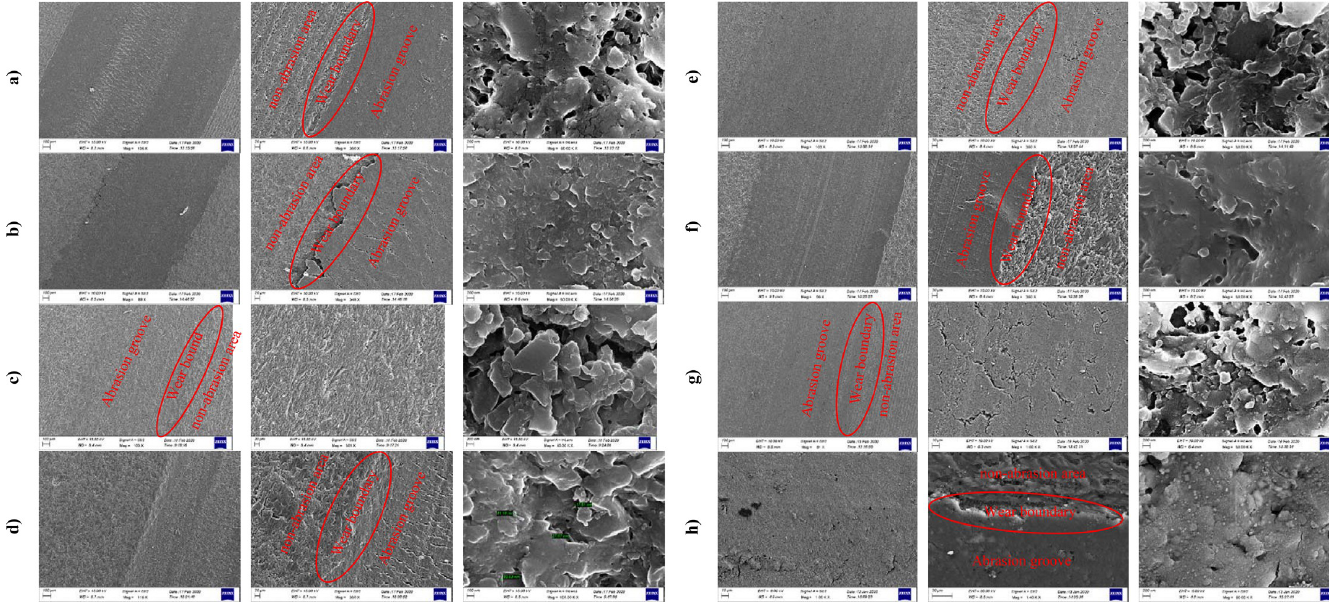
Fig 5. FESEM images of the wear surfaces (cross-sections) a) pure epoxy, b) NGO/epoxy, c) NC/epoxy, d) CNT/epoxy, e) NGO/CNT/epoxy, f) NC/CNT/epoxy, g) NGO/NC/epoxy, h) NGO/NC/CNT/epoxy.